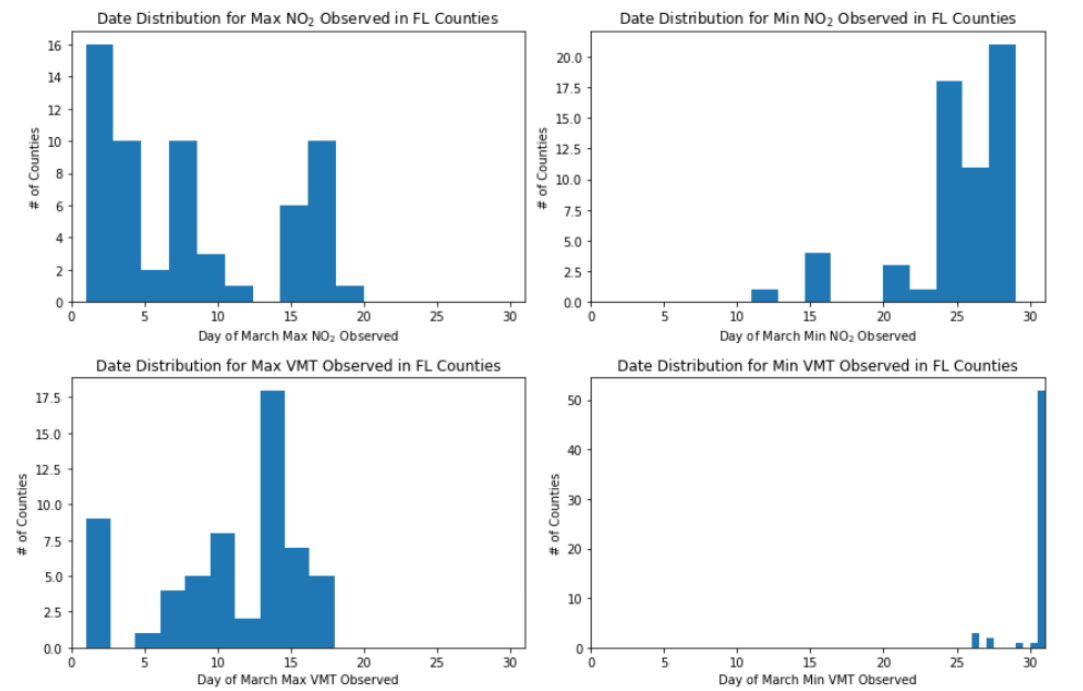
Figure 6. Date on which maximum and minimum values were observed for 7-day moving averages of VMT and NO 2 concentrations among Florida counties.